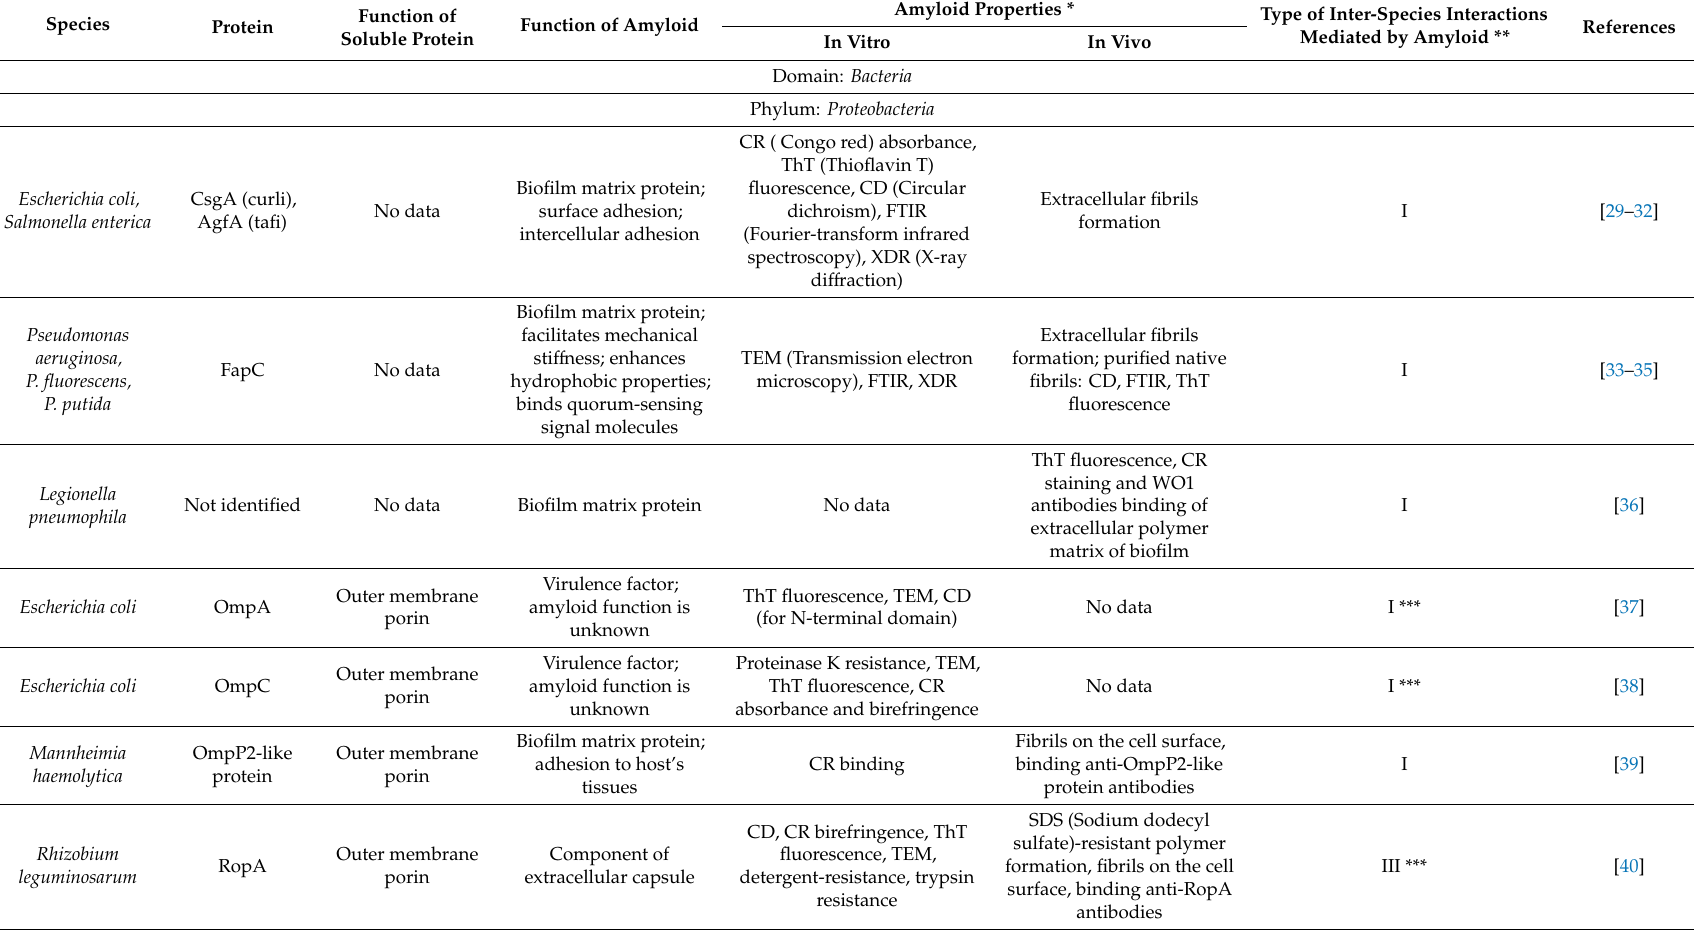
Table 1. Amyloidogenic proteins of prokaryotes, their properties, functions, and involvement in the interspecies